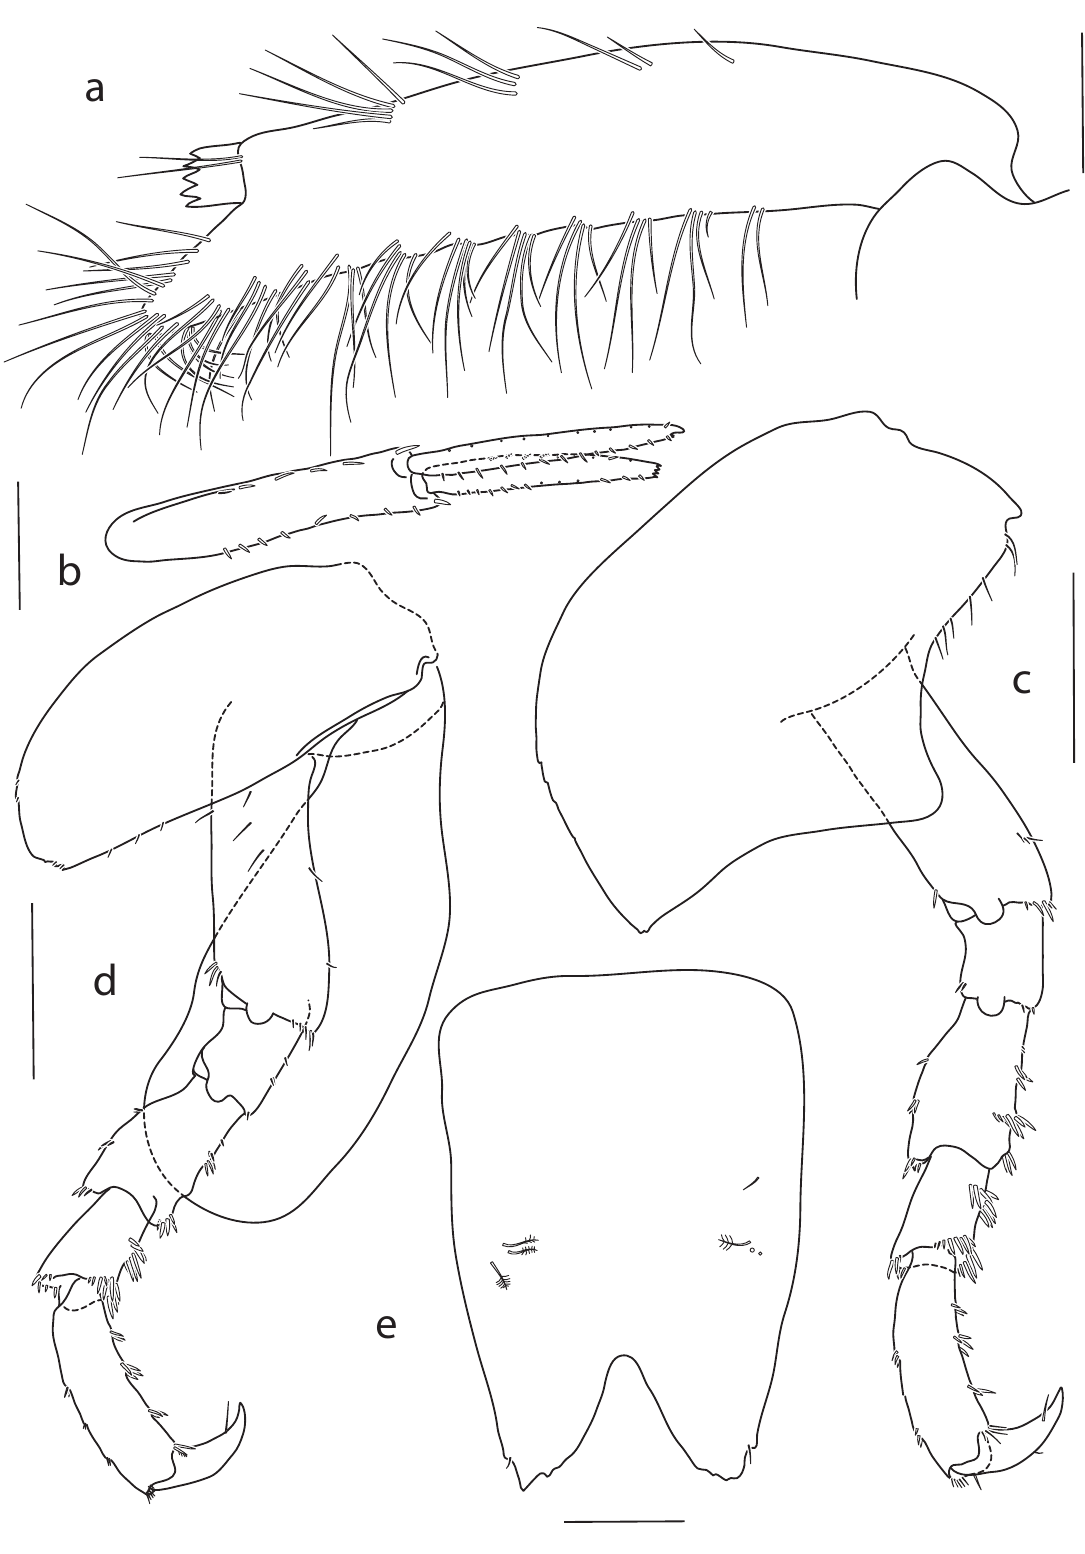
Fig. 21. Labriphimedia vespuccii K.H. Barnard, 1931, ♀, 21 mm (ZMB 34096). a . Propodus of gnathopod 2, dactylus damaged. b . Uropod 1. c . Pereopod 4. d . Pereopod 3. e . Telson. Scale bars: a = 200 µm; b–d = 1 mm; e = 200